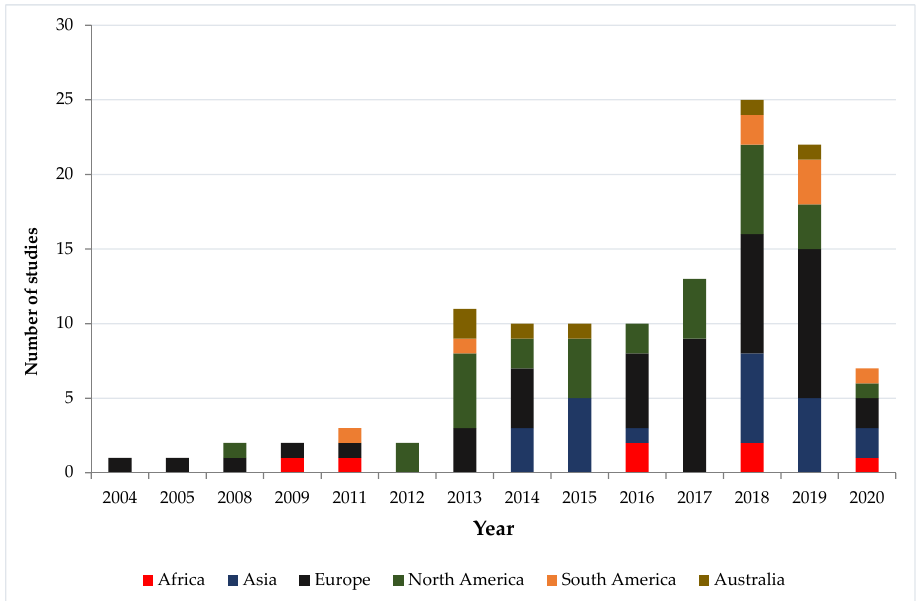
Figure 2. Number of published studies per year and continent. Over the past 15 years, research on TLS for vegetation assessments has increased significantly and knowledge has been generated especially for the European, North American and Asian region. Please note that the low number of studies in 2020 is an artefact of the review period ending on 31 May 2020. The geographic distribution of the reviewed studies by country is shown in Figure 3. To date, most studies were conducted in the United States, China and Finland. From a continental perspective, Europe has the highest number of studies (38 %) [84–86] followed by North America (24 %) [46,59,87] and Asia (19 %) [88–90]. Africa (6 %), Australia (5 %) and South America (7 %), with more than half of their landmass belonging to the savanna biome [1,2], had few TLS studies [64,91,92]. The geographic distribution of studies by biome (after Olson et al. [93]) and the per- centage of reviewed studies per biome are shown in Figure 3 and Figure 4. Studies that were conducted in more than one biome were counted multiple times and four laboratory studies were excluded from this analysis, resulting in a sample size of n = 114. The re- viewed papers covered a total of 11 biomes. While most studies were conducted in tem- perate forests (47 %) [75,94,95], much less papers were published in boreal (16 %) [96–98], tropical and subtropical forests (10 %) [99–101] as well as grasslands and savannas (9%) [70,91,92]. The cumulative total for the savanna biome was 13 %, including 4 % of savanna research conducted in temperate regions (“Temperate Grasslands Savannas and Shrub- land”).